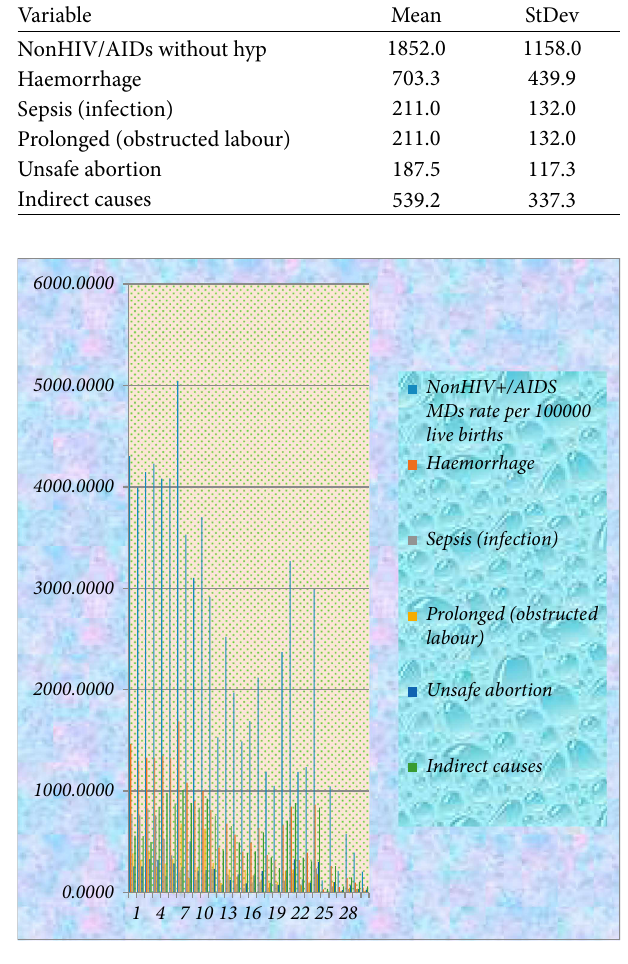
Figure 1: The yearly frequency plot of the five major causes of (nonHIV/AIDs MDs and MMR) in South